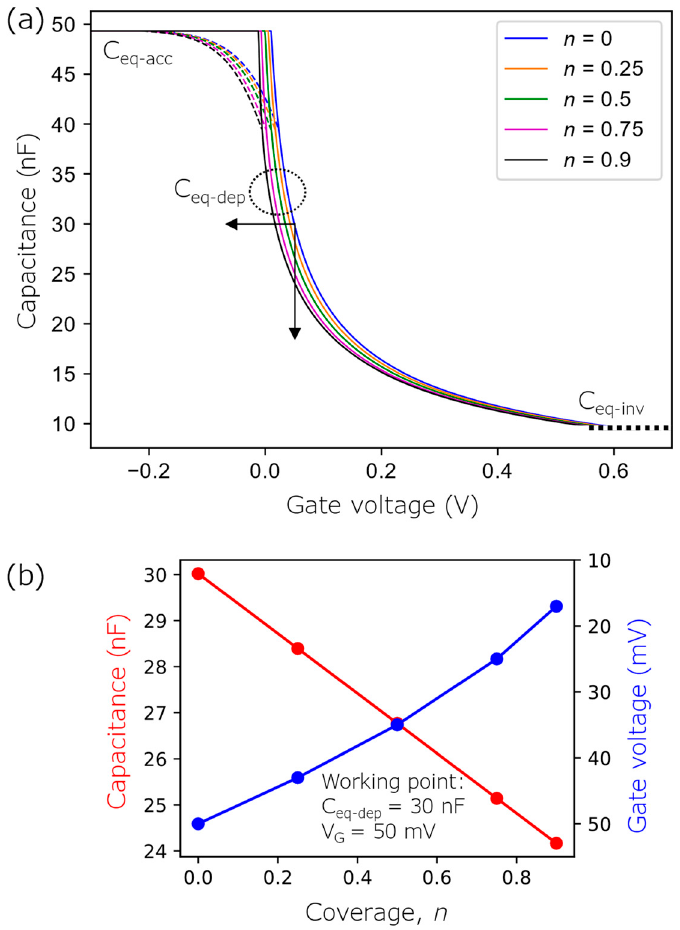
Figure 2. ( a ) Simulated C – V curves of a bare, p-type EISCAP and an EISCAP decorated with positively charged AuNPs with different coverages n (from 0.25 to 0.9). The dashed curves illustrate the expected course of the overall equivalent capacitance of the EISCAP in the transition region from depletion to accumulation. ( b ) Capacitance changes (at a constant gate voltage of V G = 50 mV) and voltage shifts (at a constant capacitance of C eq-dep = 30 nF) as a function of the AuNP coverage, evaluated from the C – V curves.